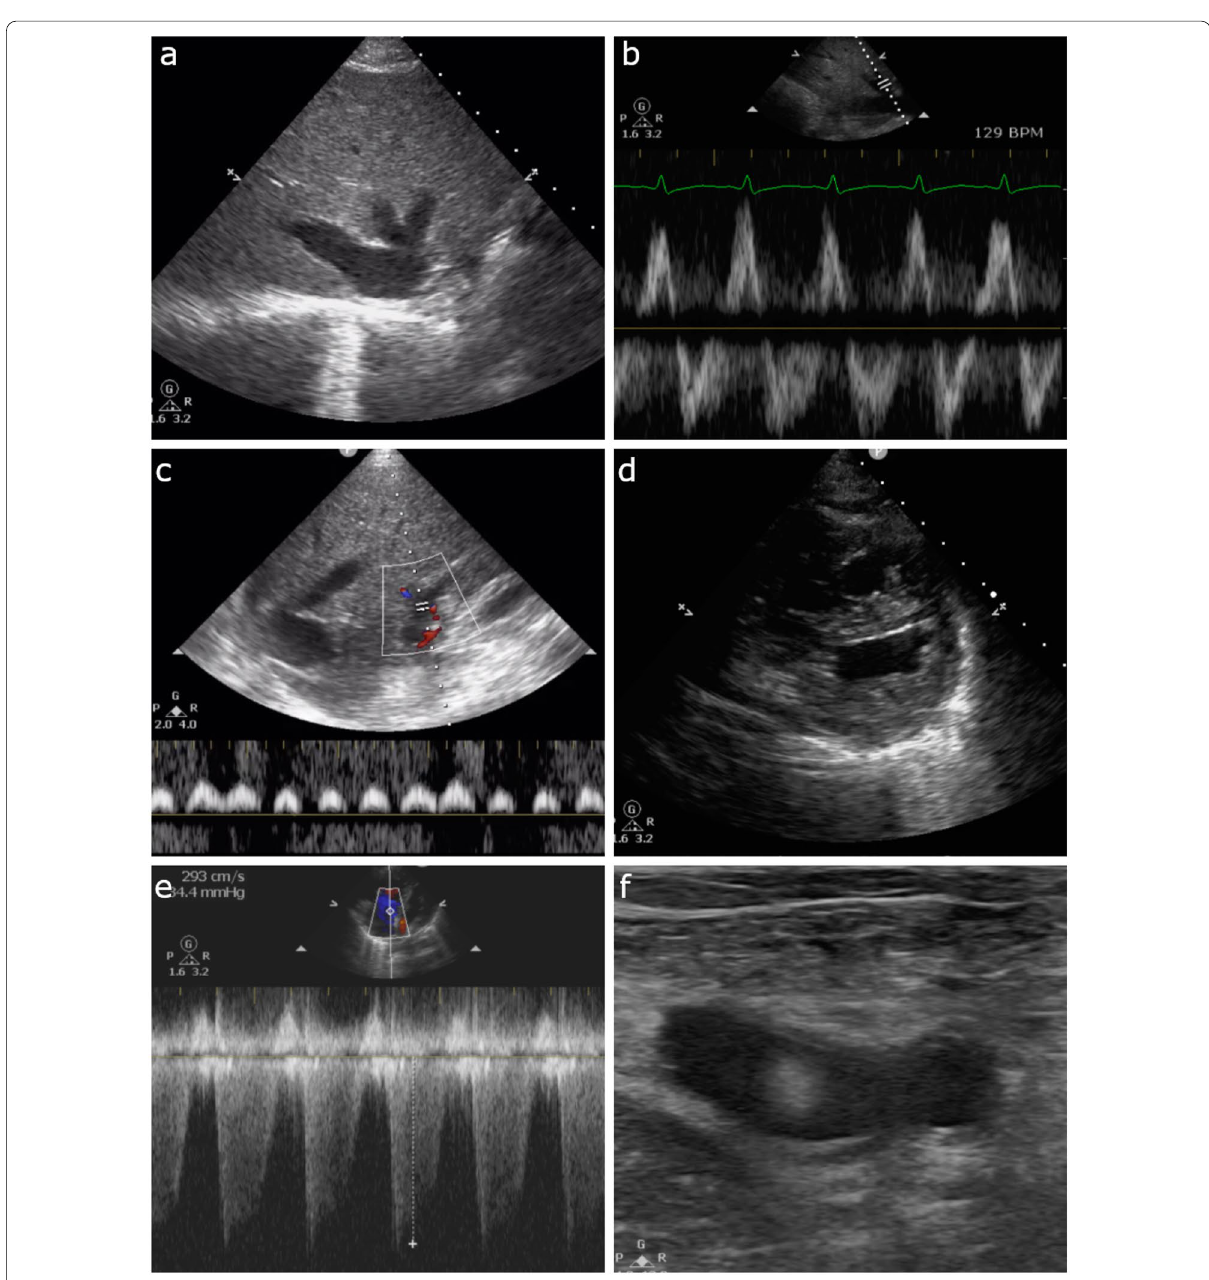
Fig. 6 Case 5: a dilated IVC. b Hepatic vein Doppler with retrograde S wave. c Portal vein Doppler with 100% pulsatility. d PSAX view of the heart with D‑shaped left‑ventricle. e CW Doppler at the tricuspid valve showing tricuspid regurgitation. d Mobile clot seen in the left femoral